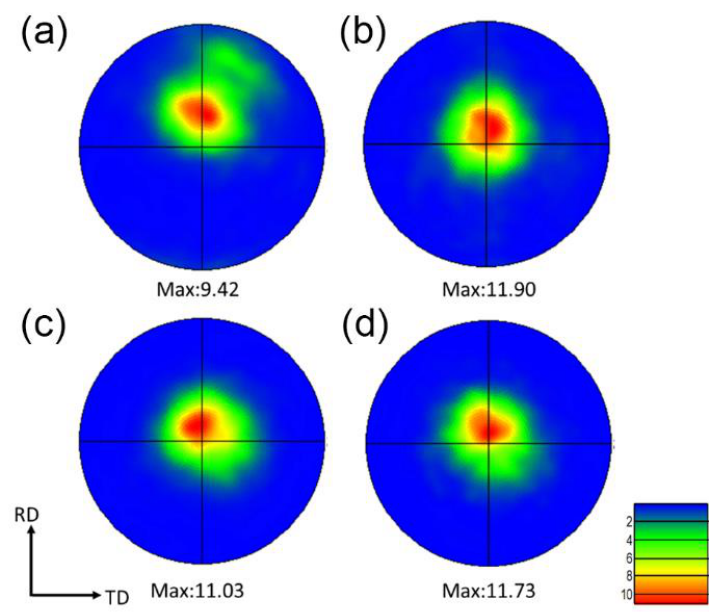
Figure 7. {0001} pole figures of the plates: ( a ) as-rolled, with the same plate annealed: ( b ) 250 ◦ C, ( c ) 275 ◦ C, and ( d ) 300 ◦ C for a fixed time of 15 min.